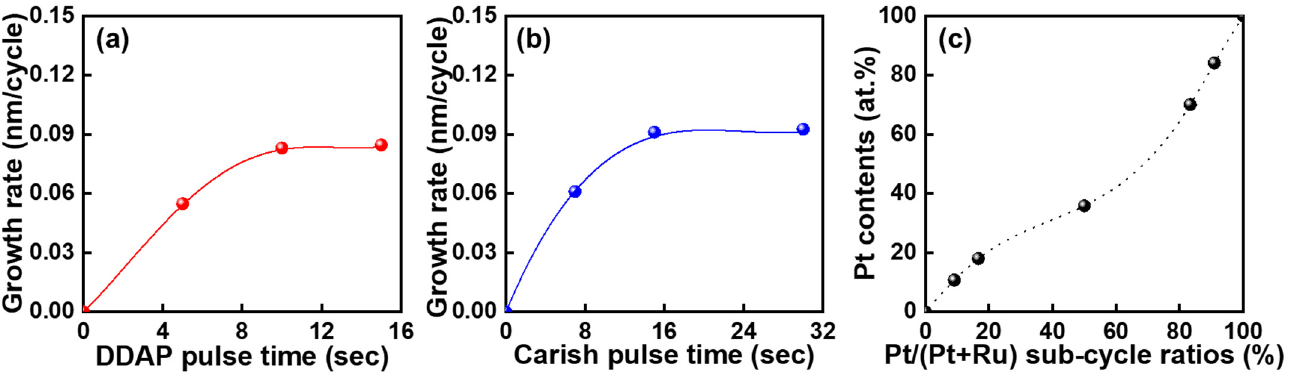
Figure 1. Growth rate of ( a ) ALD ‐ Pt depending on the DDAP pulse time, and ( b ) ALD ‐ Ru depend ‐ ing on the Carish pulse time at a deposition temperature of 340 °C. In addition, ( c ) compositions